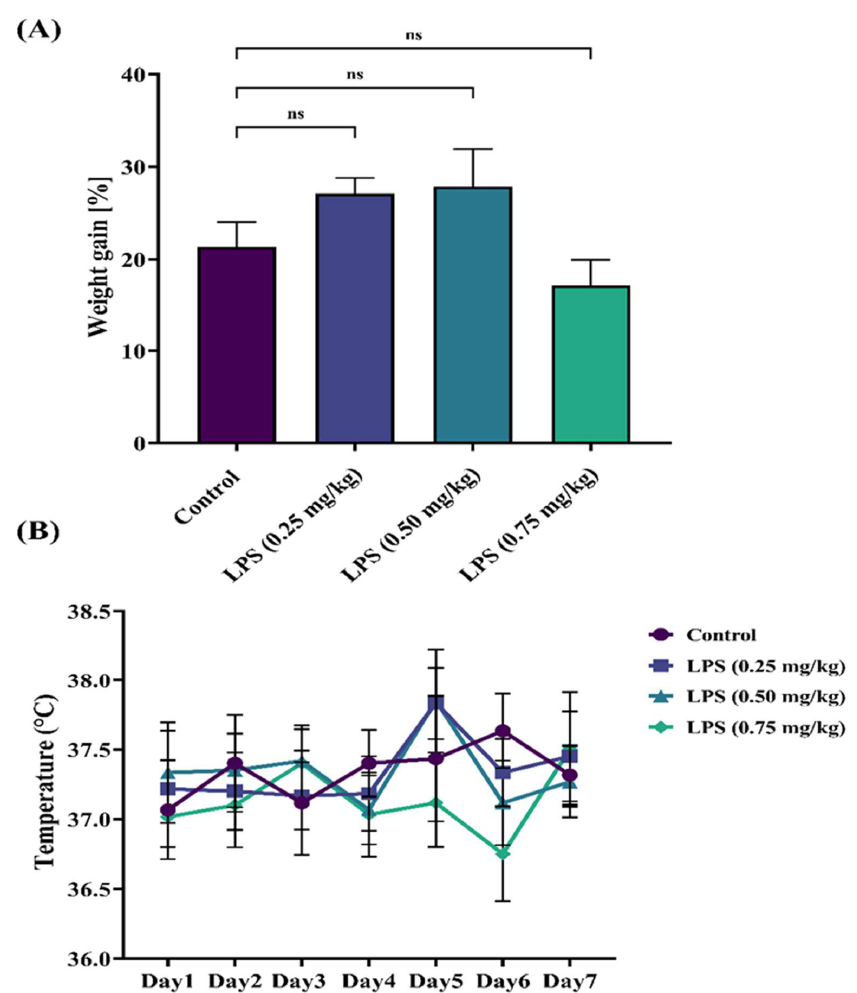
Figure 2. Weight and temperature. Weight gain and temperature were recorded daily during LPS administration. The body weight and temperature of mice showed no significant differences between the LPS groups (0.25 mg/kg, 0.50 mg/kg, and 0.75 mg/kg) and the control group. The data are presented as the mean ± SEM. ( A ) One-way ANOVA was used. ( B ) Two-way ANOVA was used. ns = non-significant. LPS: lipopolysaccharide; SEM: standard error of the mean; ANOVA: analysis of